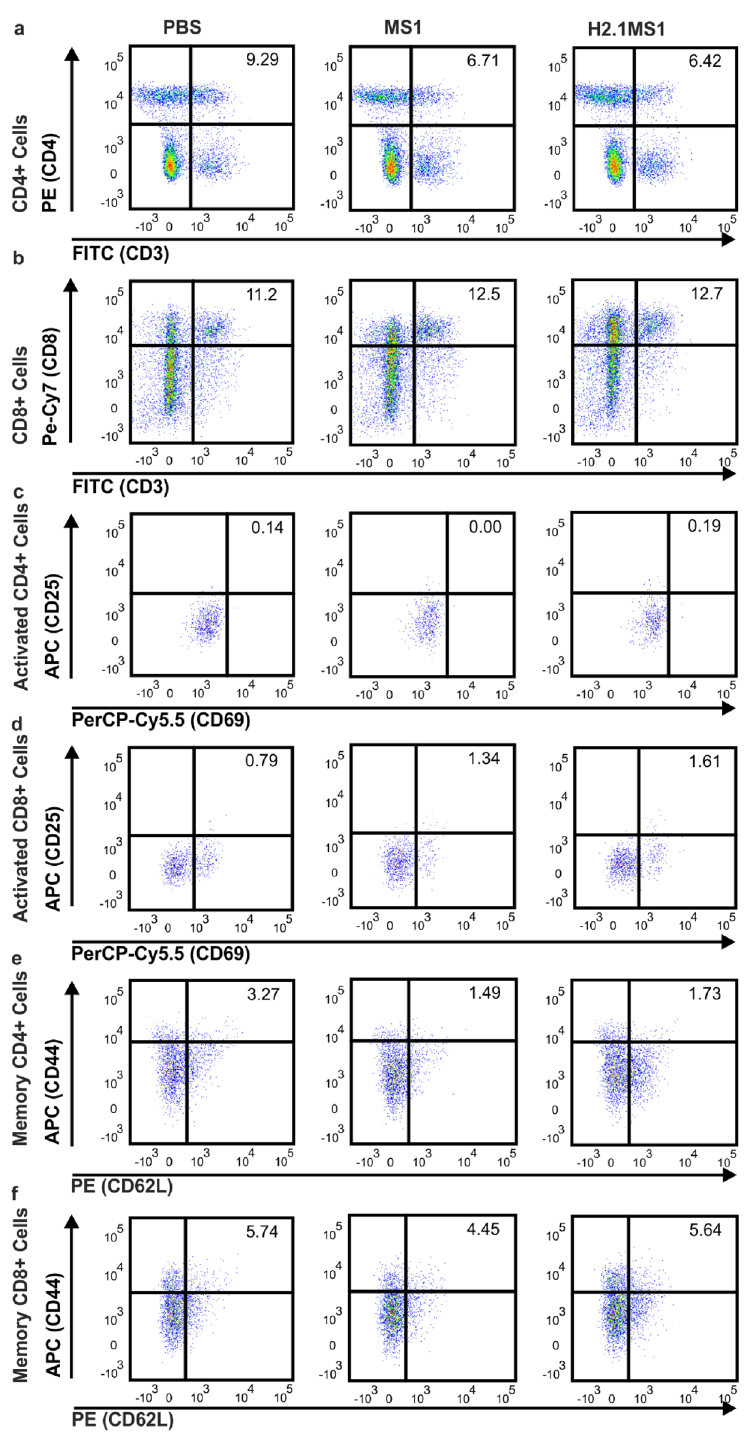
Figure 5. Phenotypes of splenocytes isolated from mice receiving PBS, MS1 or H2.1MS1 spheres. Mice were intravenously administered PBS, MS1, or H2.1MS1. After 14 days, the spleens were collected and pooled for each research group, and the phenotypes of the splenocytes were analyzed by flow cytometry. ( a ) CD4 + lymphocytes (CD3 + CD4 + ), ( b ) CD8 + lymphocytes (CD3 + CD8 + ), ( c ) activated CD4 + lymphocytes (CD3 + CD4 + CD25 + CD69 + ), ( d ) activated CD8 + lymphocytes (CD3 + CD8 + CD25 + CD69 + ), ( e ) memory CD4 +